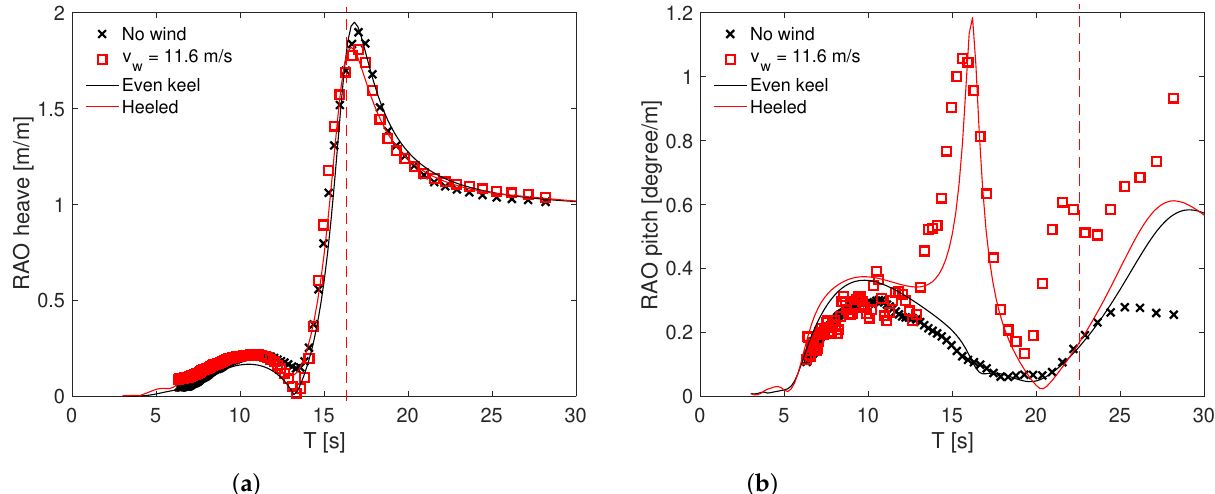
Figure 16. Numerical and experimental RAO for concomitant wind and waves for v w = 11.6 m/s (without TA): ( a ) heave and ( b ) pitch. The dashed lines represent the experimental natural periods from Table